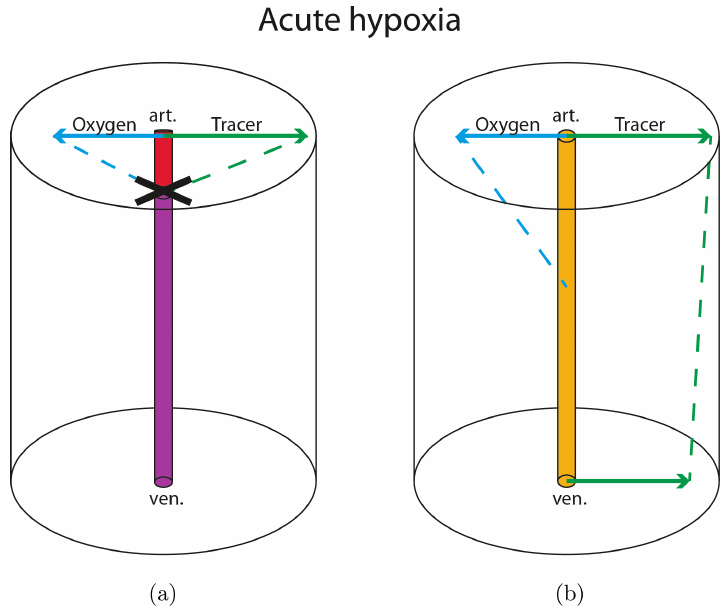
Fig. 3. Acute hypoxia. Schematic representation of the radial di®usion distances for oxygen (blue) and hypoxia tracer (green) within a tissue cylinder surrounding a straight tumor capillary running from the arterial (art.) to the venous end (ven.). (a) Temporary vascular obstruction near the arterial end of the capillary (black cross). Desaturated, non°owing blood is present distal to the point of vascular occlusion (purple). (b) E®ect of transient sole plasma °ow (yellow) on the oxygen and tracer di®usion distances in acute hypoxia. The broken lines represent the critical di®usion distances for both substances.